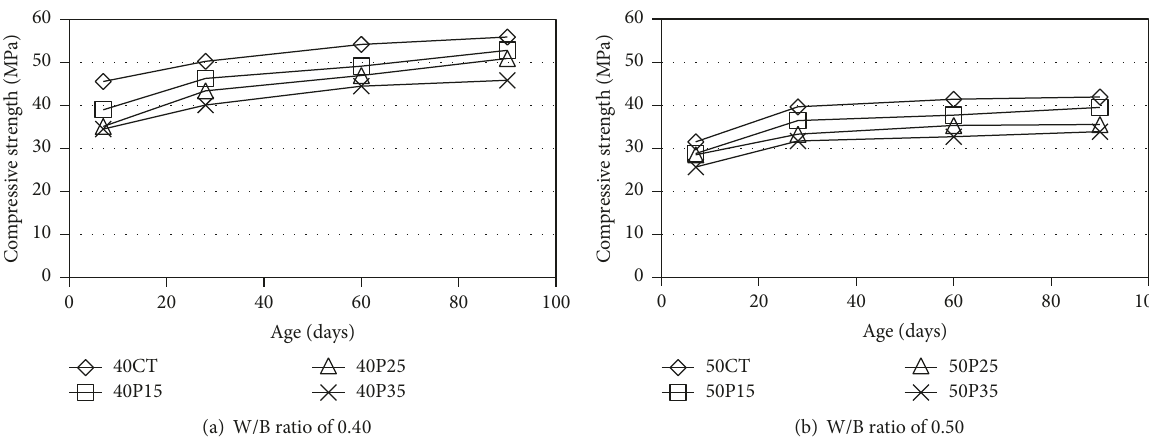
Figure 3: Compressive strengths of the concrete at different